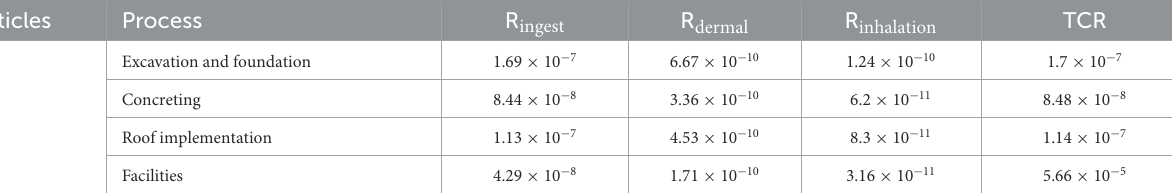
HQ,hazardquotient. TABLE 4 Risk potential values and risk index for PM 10 cancer